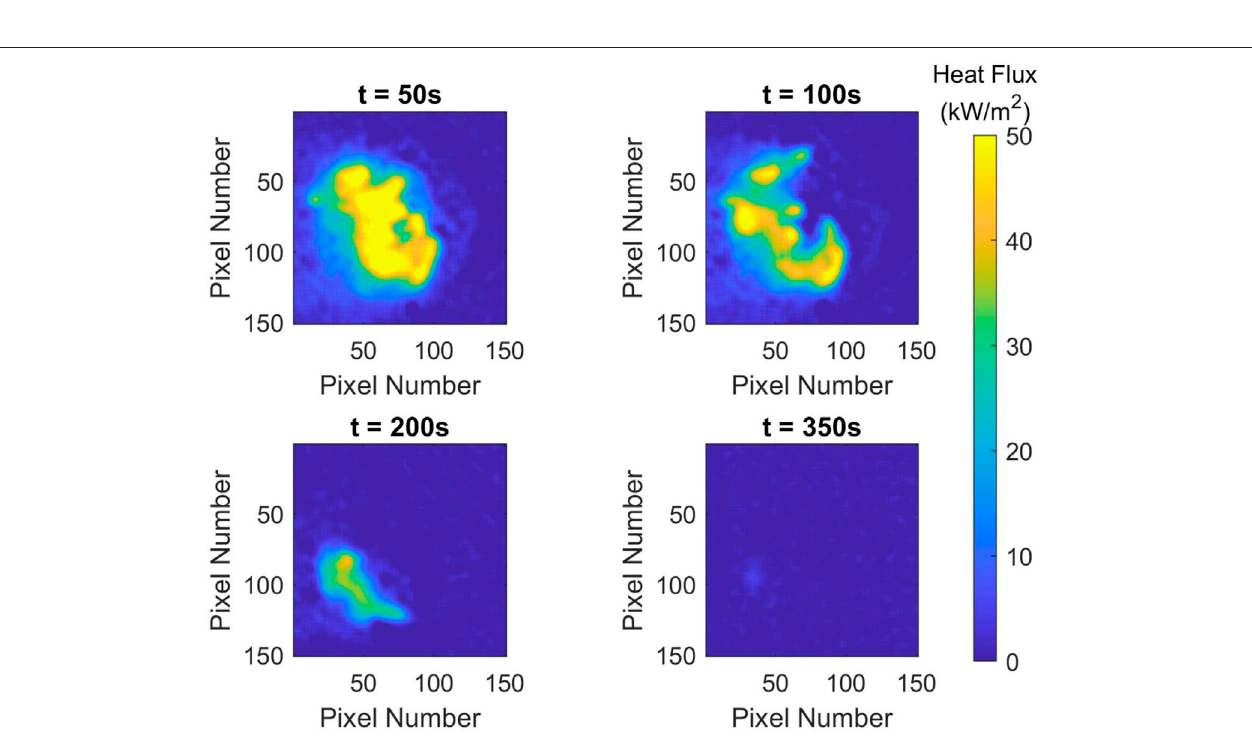
Frontiers in Mechanical Engineering |